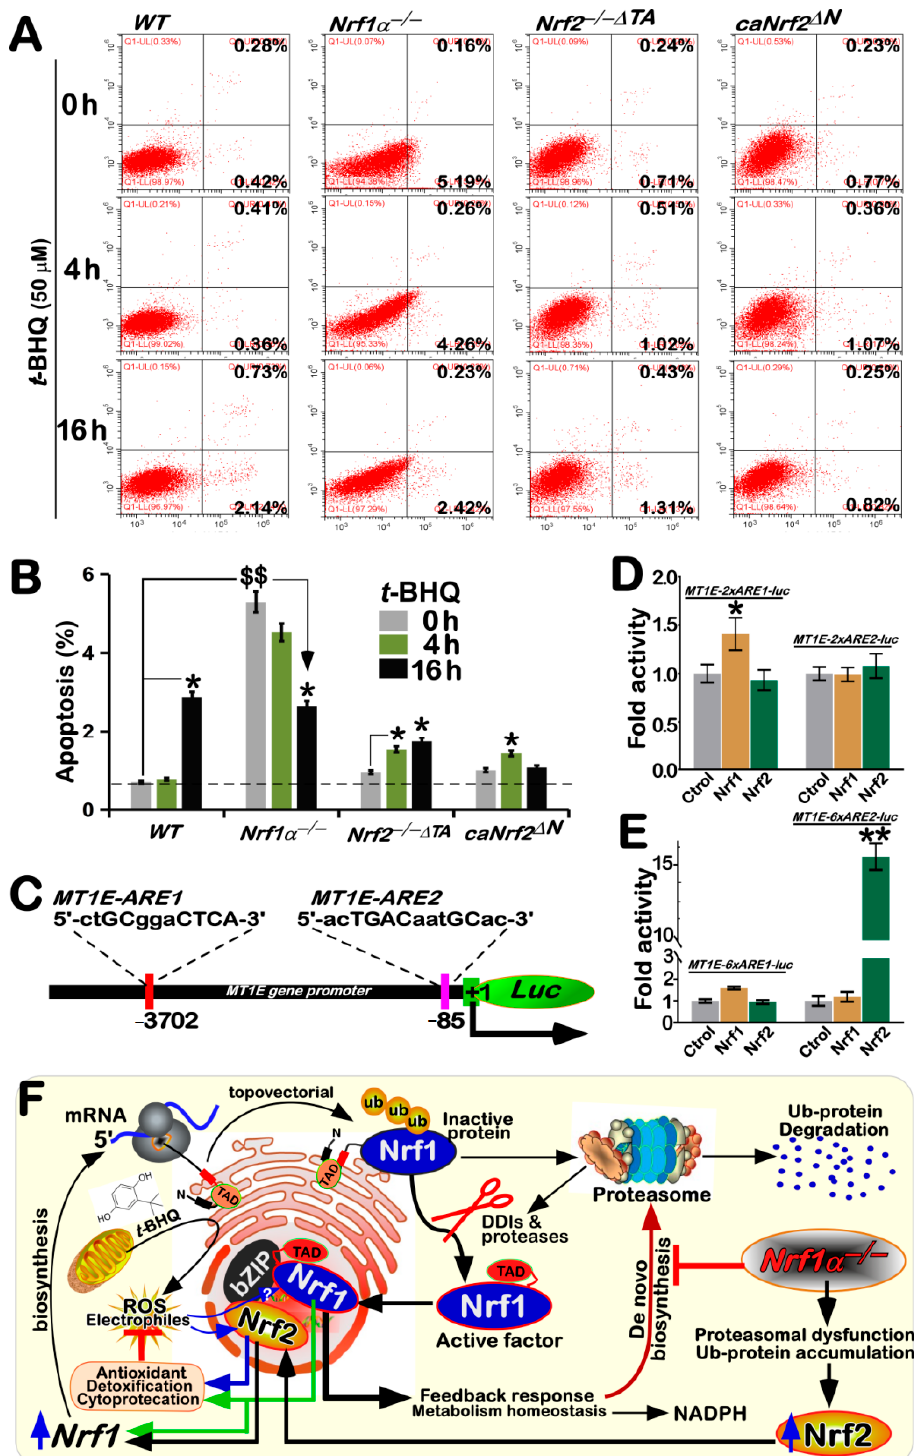
Figure 6. Nrf1 is more potent than Nrf2 at mediating the putative cytoprotective response to t -BHQ. ( A ) Distinct genotypic cell lines of WT , Nrf1 α − / − , Nrf2 − / −Δ TA , and caNrf2 Δ N were or were not treated with 50 μ M t BHQ for different lengths of time. Subsequently, the cells were incubated with a binding buffer containing Annexin V-FITC and propidium iodide (PI) for 15 min, before being subjected to the flow cytometry analysis of apoptosis. ( B ) The final results were shown by the column charts, which were representative of at least three independent experiments being each performed in triplicate. Of note, $$, p <0.01, indicate significant differences in each basal value of [ Nrf1 α − / − ] T0 , [ Nrf2 − / −Δ TA ] T0 , [ caNrf2 Δ N ] T0 versus that of [ WT ] T0 , while both * p < 0.05 and ** p < 0.01 denote significant differences of those values from each of cell lines treated by t BHQ for 4 h (i.e., [X] T4 ) or 16 h (i.e., [X] T16) versus its untreated [X] T0 value in the same group. ( C ) Two putative ARE sequences were schematically shown in the location of the MT1E gene promotor region. ( D , E ) Distinct copies of those two ARE-sequences from the MT1E gene were allowed for driving